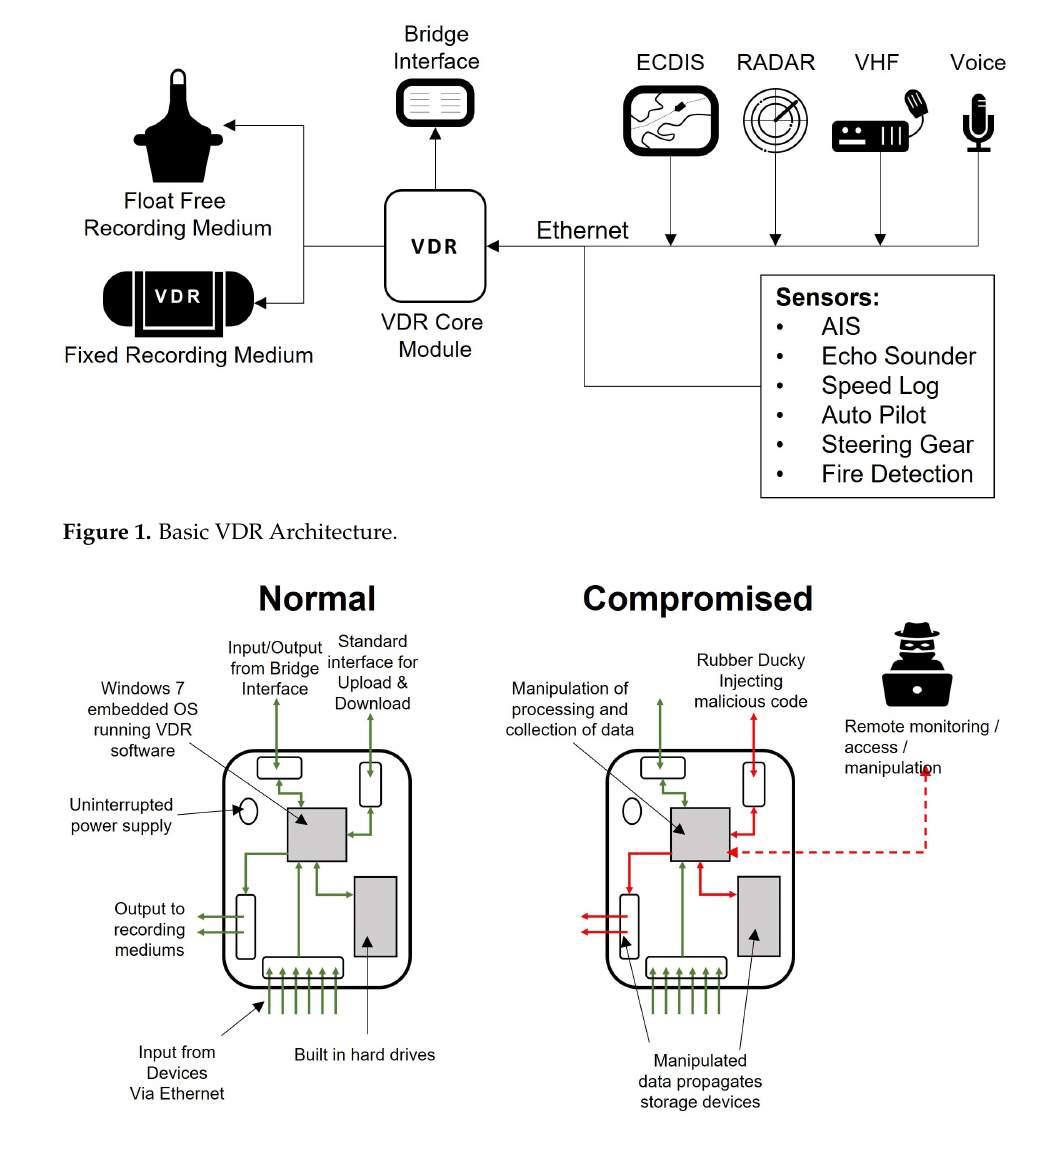
Figure 2. VDR Core Unit Components and Data Flows (normal and compromised